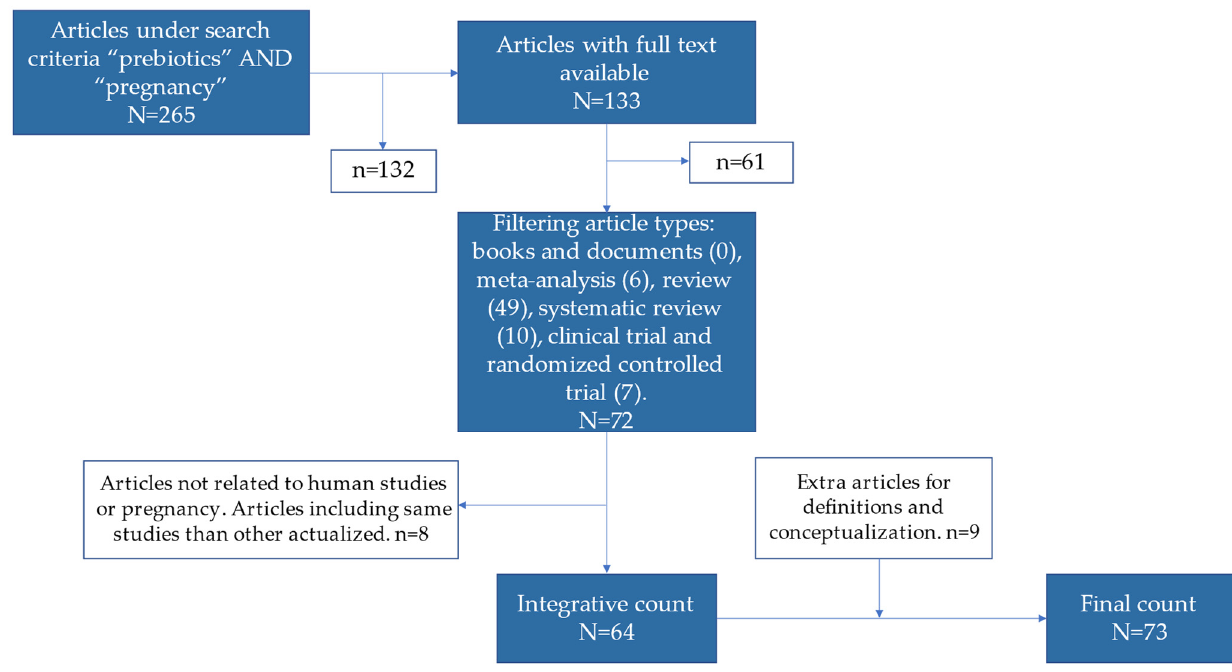
Figure 4. Flowchart of articles included in the narrative review. The picture follows the instructions from an integrative review based on PRISMA rules, but in the last step there are few articles added that convey a narrative review.